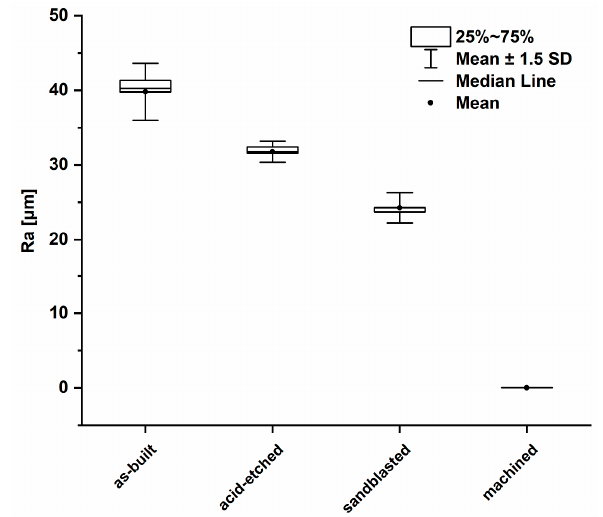
Figure 4. Box plot of the average surface roughness values (average values and standard deviation).